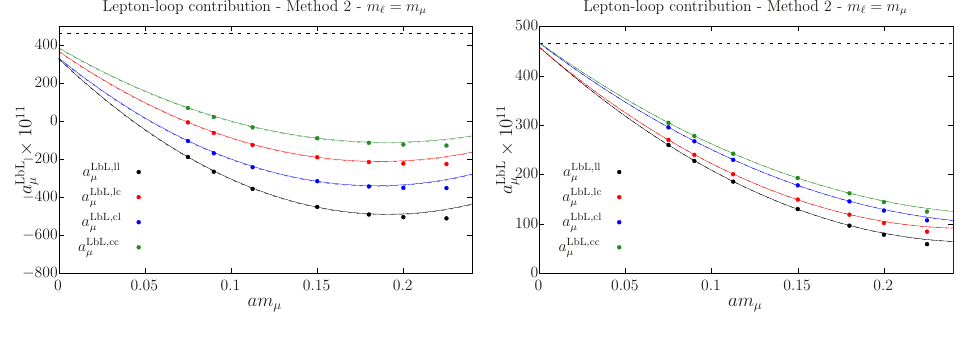
Figure 12 . Same as figure 11 but with m l = m µ